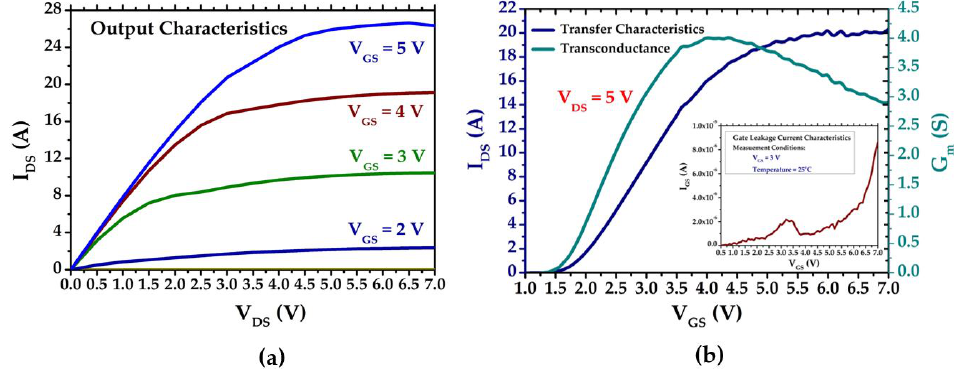
Figure 2. Representative of commercialized 200 V E-mode GaN power HEMT switch fresh electrical characteristics at room temperature: ( a ) output characteristics and ( b ) transfer